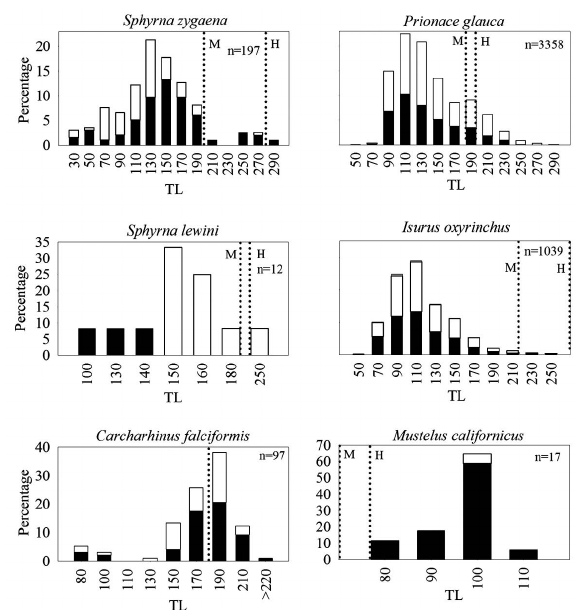
Fig . 4. – Size frequency distributions by sex of shark species cap- tured by longlines. n refers to the number of measured individuals. Females are depicted in black, males in white, unsexed specimens in grey. Dotted lines indicate the size at maturity. In cases in which a substantial difference in size at maturity exists among sexes, lines are labeled M (male) or F